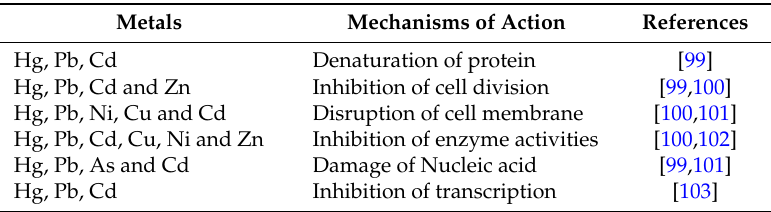
Table 2. Toxic effects of HM on